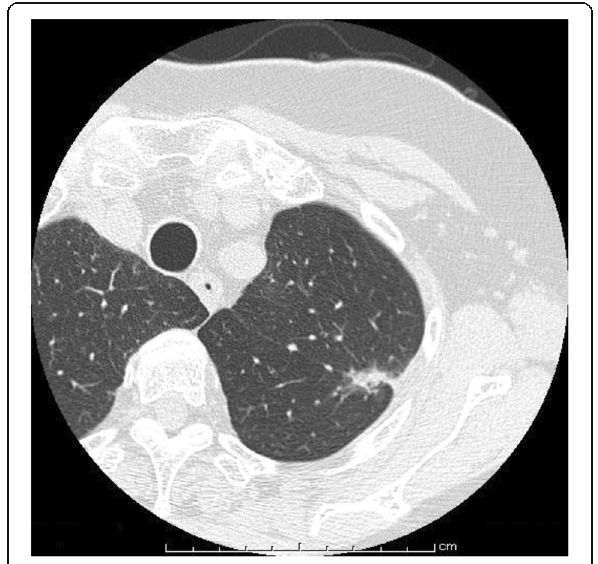
of left S1+2 with indentation. It is 22 mm in size